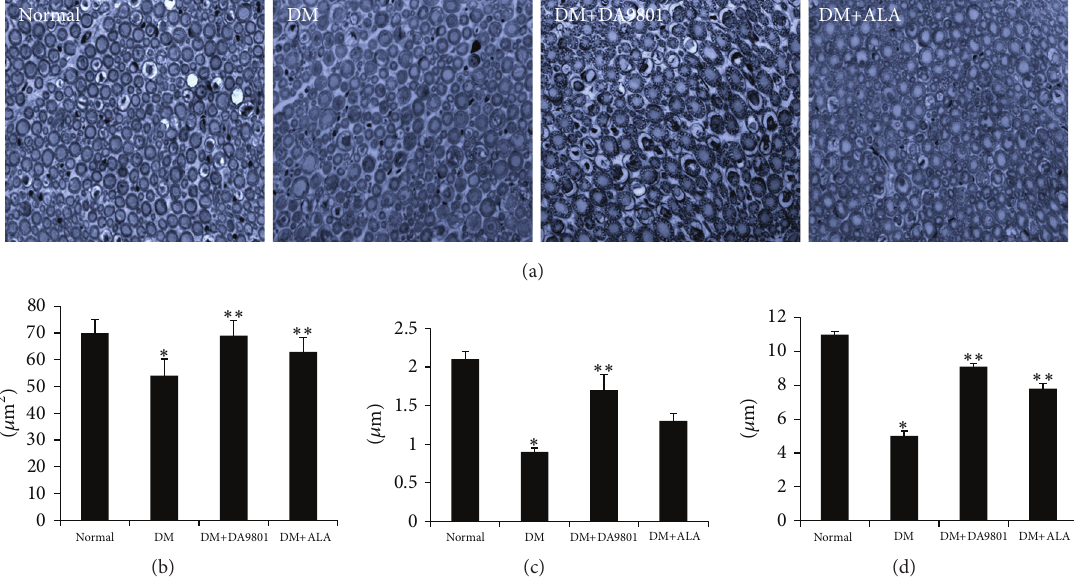
Figure 5: Immunohistochemistry of the sciatic nerve (a) and the area of myelinated nerve fiber (b), the diameter of myelin sheath (c), and the diameter of axon (d) of the experimental groups. Myelinated axonal nerve fibers were less degenerated in the DM+DA-9801 and DM+ALA groups. In addition, the size of nerve fibers with or without myelin sheath was increased in the DM+DA-9801 and DM+ALA groups as compared with the DA-9801-treated DM groups. Data are presented as means ± SD. ∗ 𝑃 < 0.05 versus Normal and ∗∗ 𝑃 < 0.05 versus DM ( 𝑁 = 10 in each group). ALA: Alpha lipoic acid and DM: